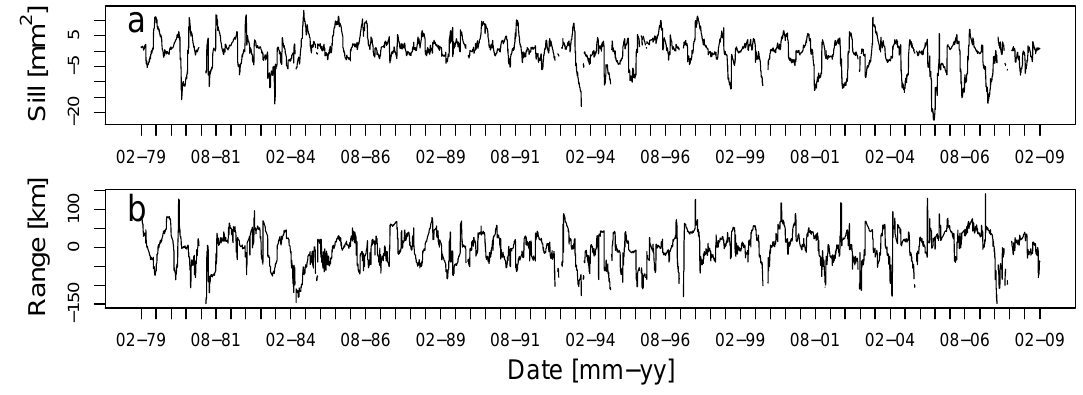
Fig. 8. The difference of the climatological fitted cosine and the actual values resulting in the anomaly of sill (a) and range (b) .